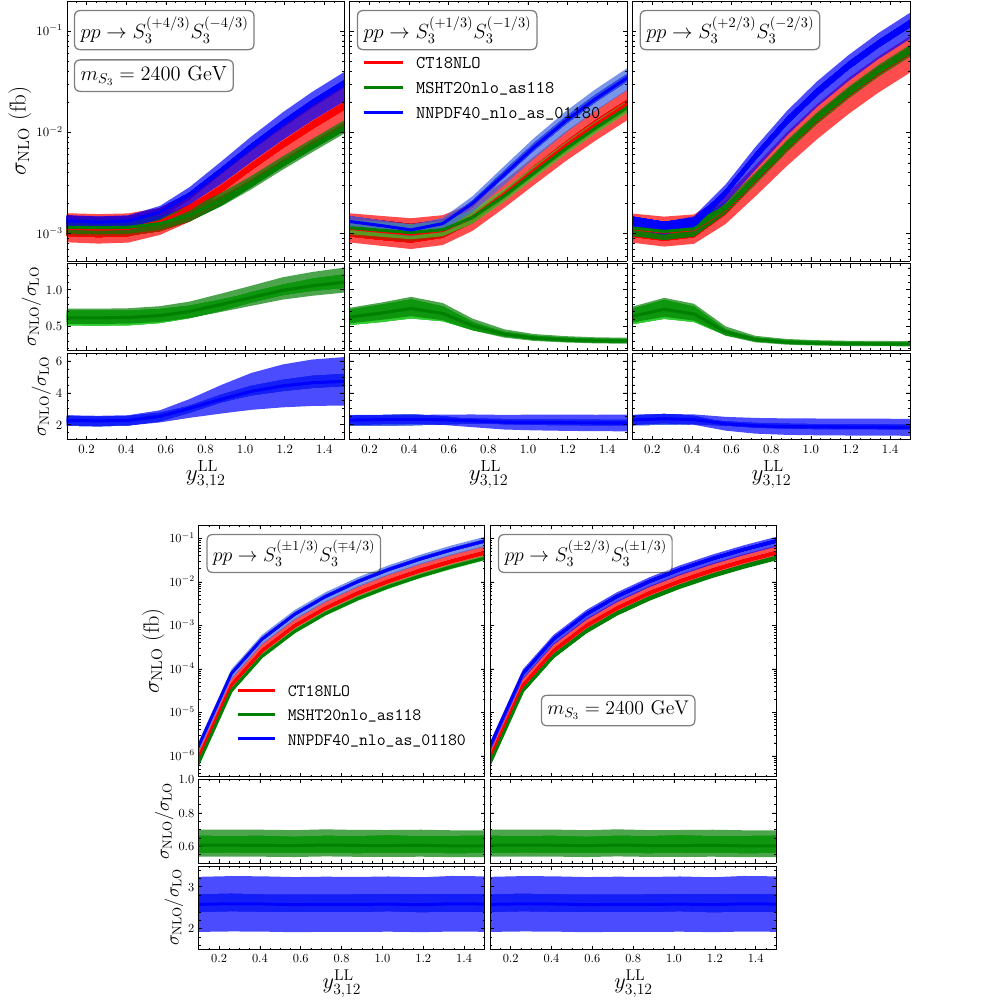
Figure 10 . Same as in figure 3 but for m R